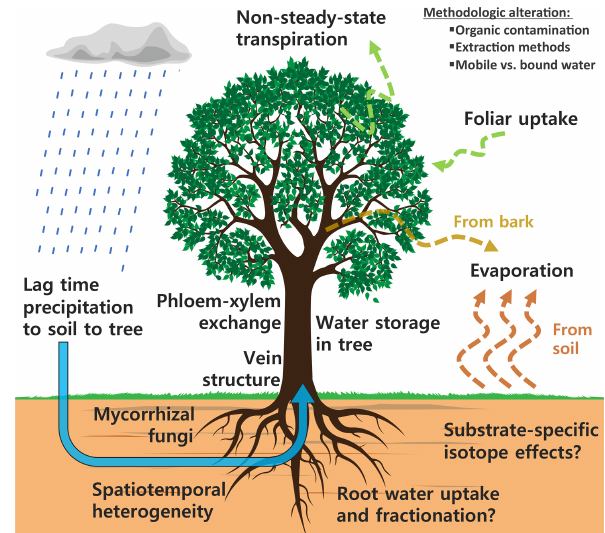
Figure 1. A compilation of isotope effects potentially affecting the soil and plant water isotope